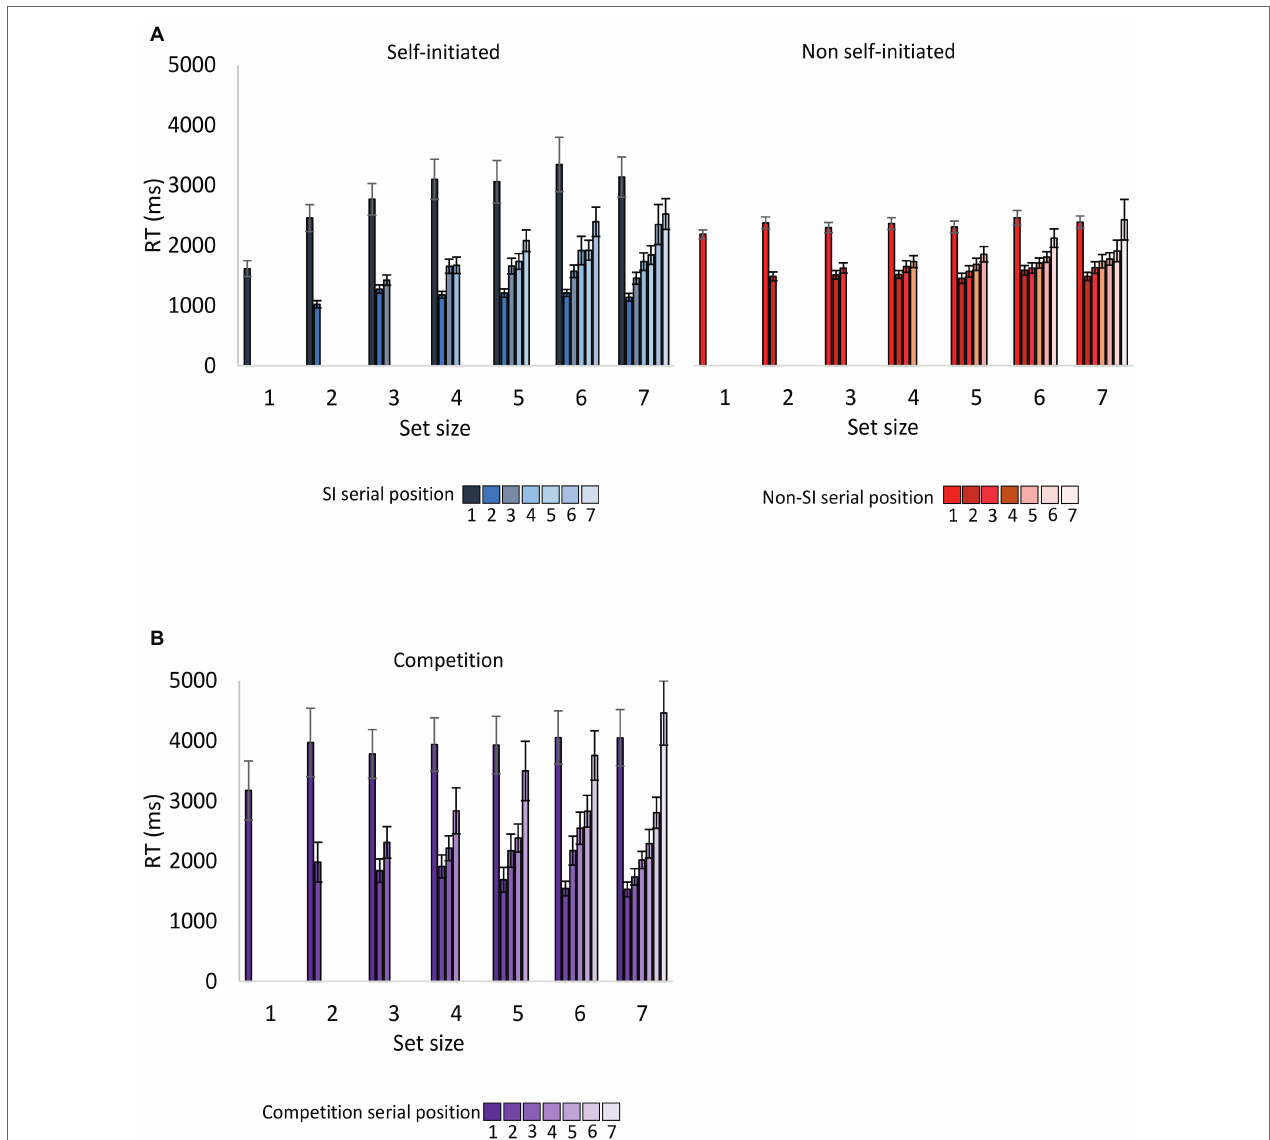
FIGURE 2 | Encoding RT as a function of encoding condition, serial position and set size for (A) Experiment 1 (B) Experiment 2. Except for the first target, encoding RT for each target was calculated with respect to the selection of the previous target in the sequence. Error bars represent standard error of the mean. SI,